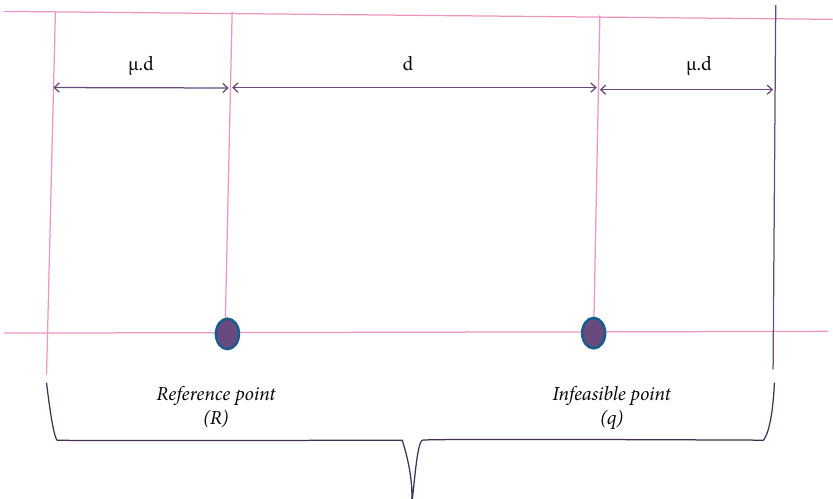
Figure 2: Probable sample location for the produced solution by repairing infeasible